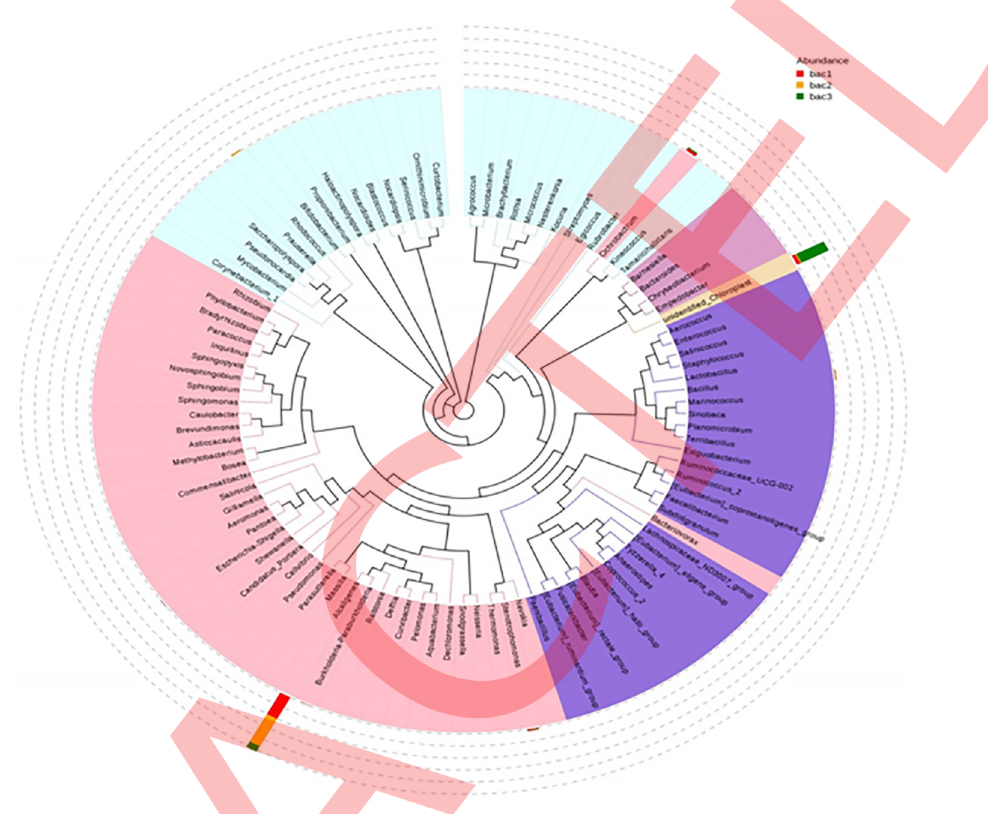
Fig 4. The evolutionary tree based on the genus of bacterial endophytes from citrus